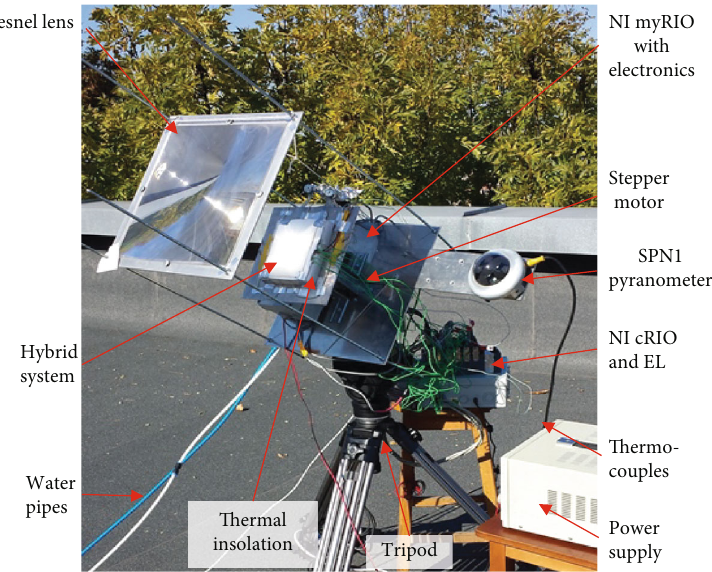
Figure 3: Experimental